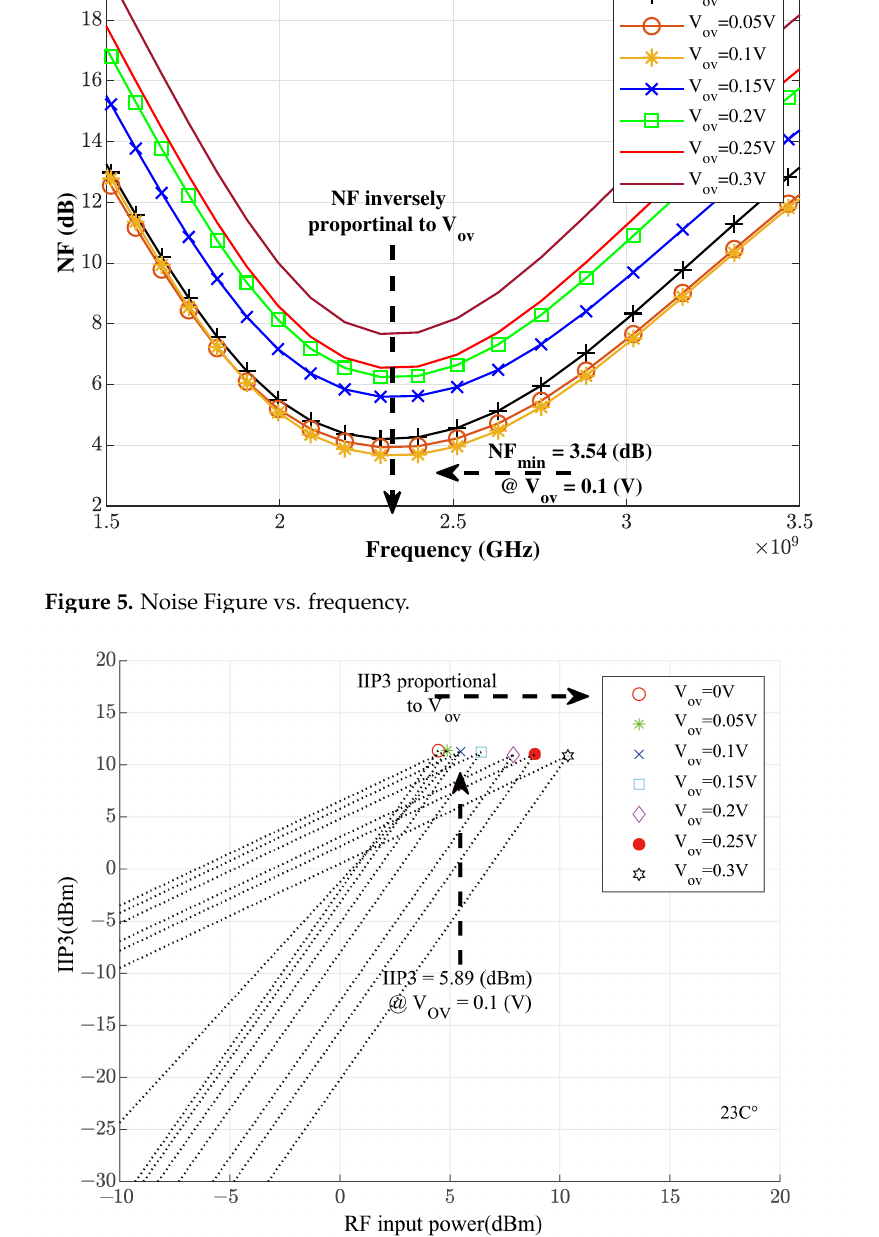
Figure 6. Third-order intercept point vs. V ov